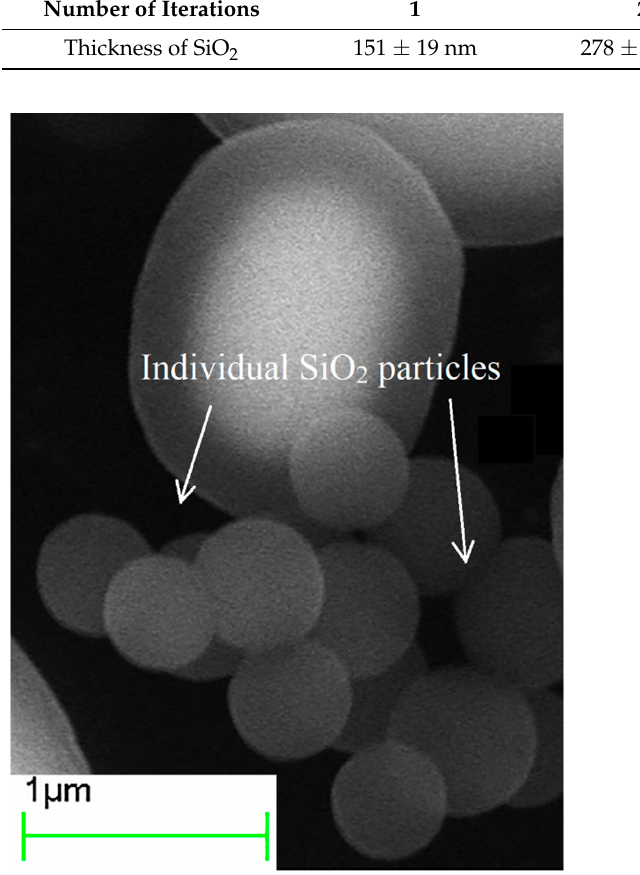
Figure 3. Images of individual SiO 2 particles.